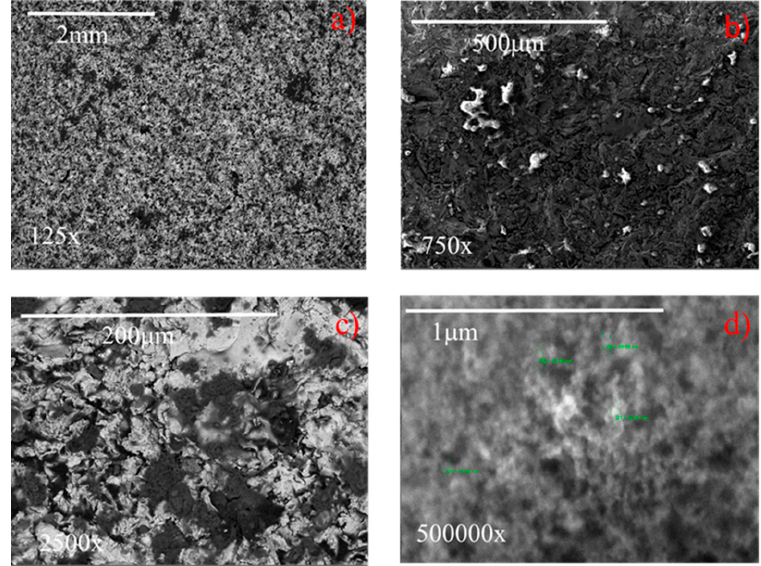
Figure 15. SEM images at different magnifications of a sample having an original roughness of sample 7 ( a ) 125×, ( b ) 750×, ( c ) 2500×, ( d ) 500,000×.